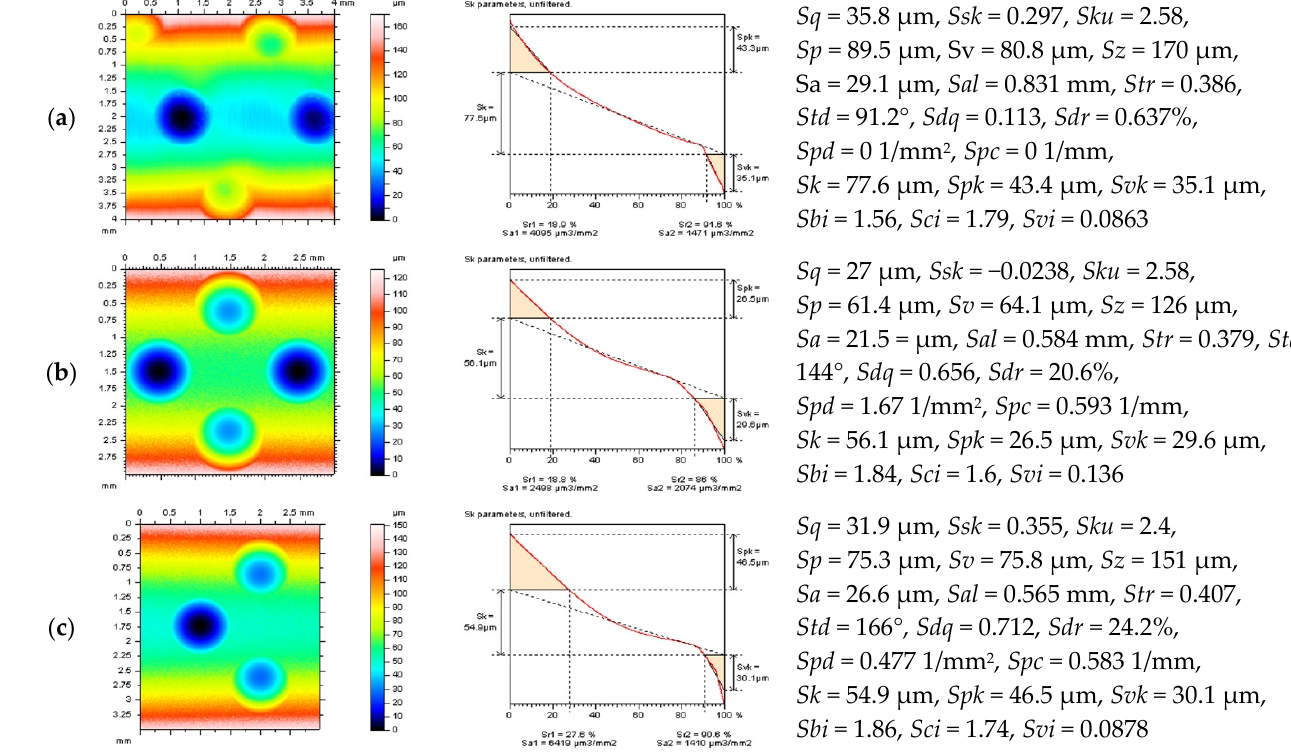
Figure 4. Contour map plots (left column), material ratio curves (middle), and surface texture parameters (right column) of the cylindrical surfaces after turning process ( a ) and isotropic ( b , c ) with different dimple distribution.